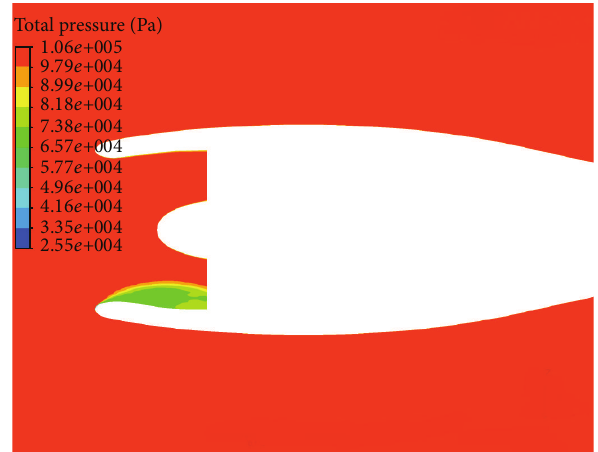
Figure 16: Contours of the total pressure obtained by a steady state calculation.